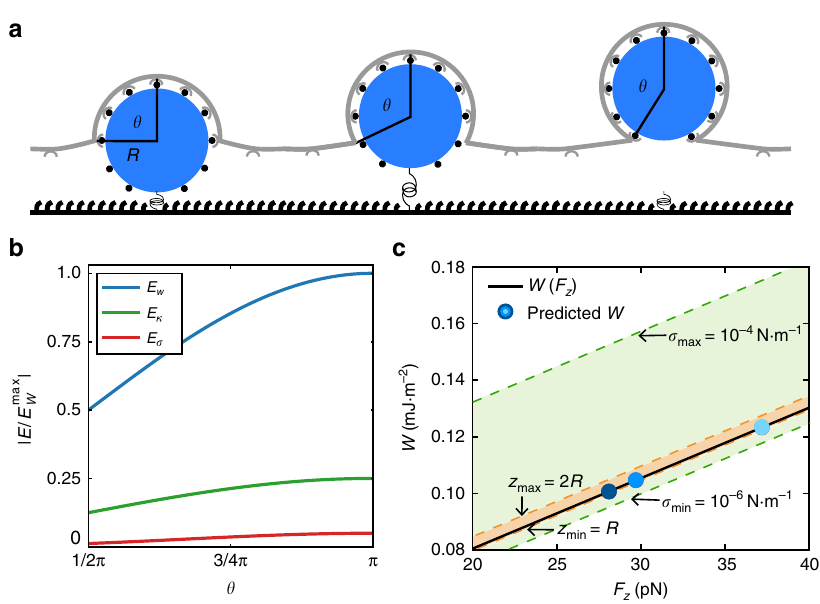
Fig. 6 Mathematical model of nanoparticle uptake provides calculated adhesion energy. a In the model the particle (blue) with radius R , immobilized by a force sensor (spring) is homogenously covered with ligands (black dots) that can adhere to the cell surface receptors (gray). We assume that initially the particle is already halfway wrapped. b Normalized energy values of contributions from adhesion energy, E W (blue), curvature energy, E κ (green), and stress energy, E σ (red), calculated according to Eq. 6. c Calculated adhesion energy density W as a function of uptake force (solid line). The orange and green region shows the uncertainty of the adhesion energy caused by the uncertainty of the rupture length z and surface tension σ , respectively. The blue points show the predicted adhesion energy for the uptake forces of AuNPs with three different